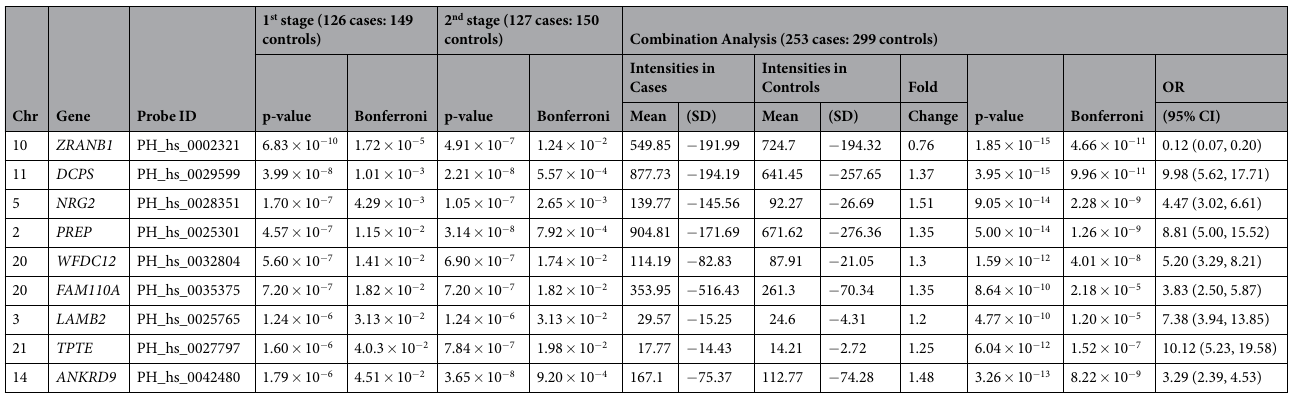
Table 3. Results of the 1st stage and 2nd stage gene expression association studies. * Bonferroni = (p-value x 25215); Chr: Chromosome; SD: Standard deviation; Fold Change = (average intensities in cases)/(average intensities in controls); OR: Odds ratio; CI: Confidence